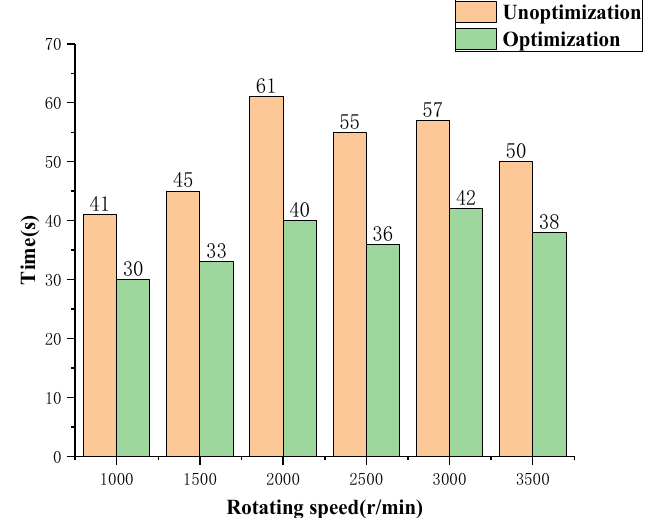
Figure 12. Comparison of balance time.